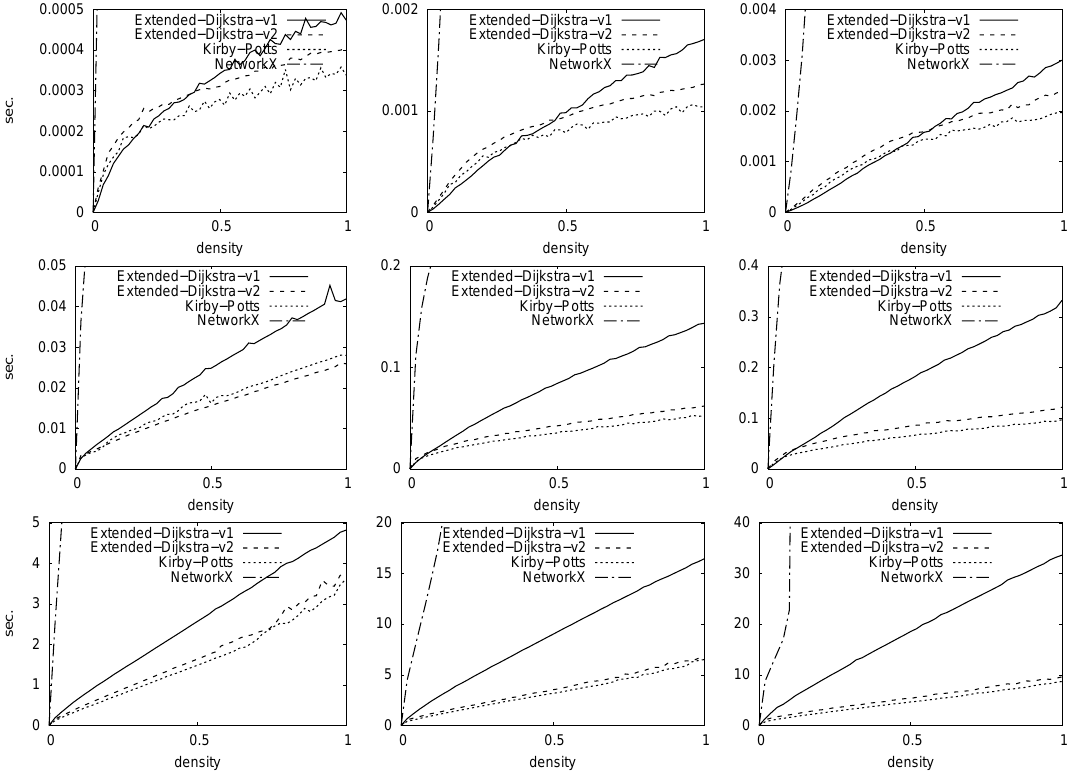
Figure 7. CPU times required to produce a shortest path tree from a single source using random graphs of differing densities. Rows show n values of 100, 1000 and 10,000 respectively; columns consider k -values of 3, 10 and 20 respectively. The number of edges in a graph is determined by multiplying the density by n ( n − 1 )